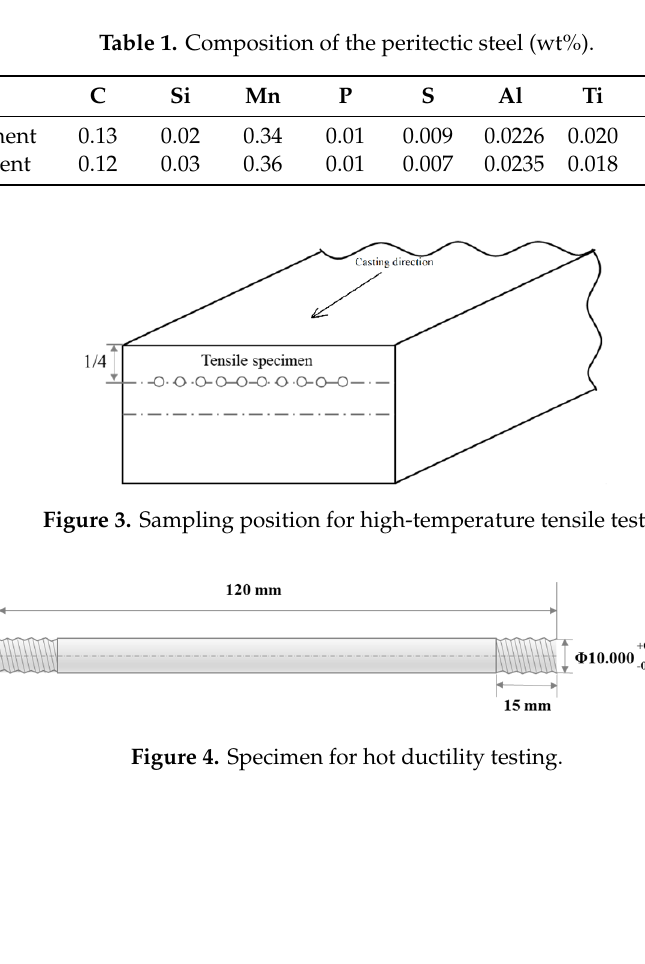
Figure 5. Temperature setting for the tensile test.